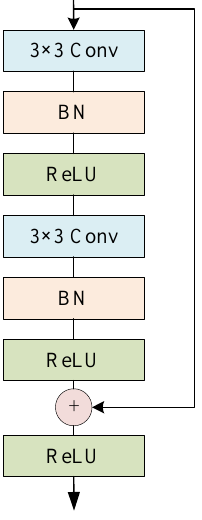
Figure 2. Structure of the residual